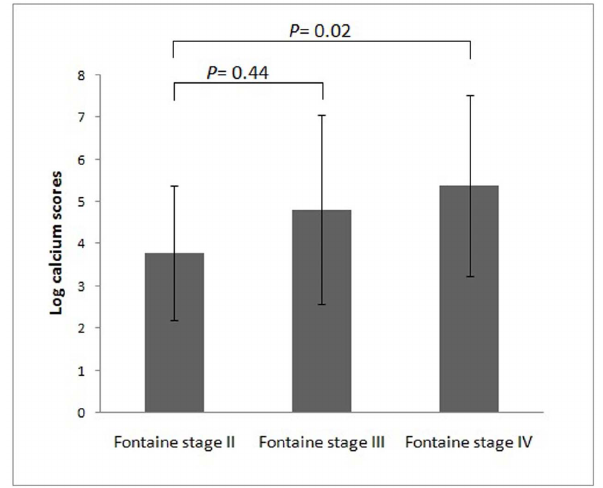
Figure 1. The lower extremity arterial calcium scores in peripheral artery disease patients with different Fontaine stages.